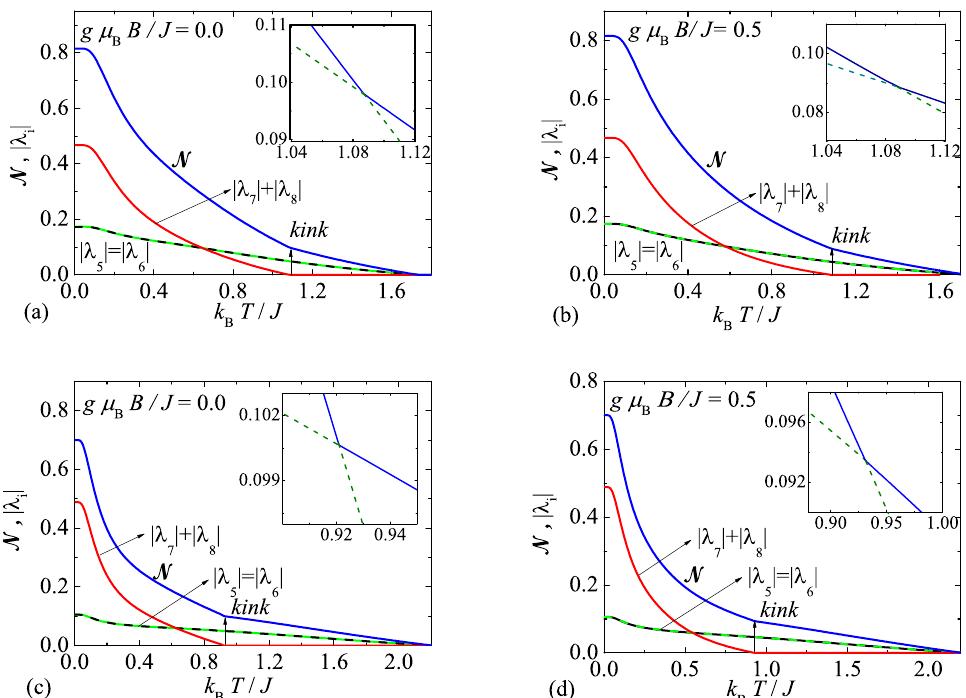
Figure 4. ( a , b ) Temperature dependencies of the overall negativity N and its three individual contributions N 1 , N 2 , and N 3 for the spin-1 Heisenberg dimer with the isotropic exchange coupling ∆ = 1, the uniaxial single-ion anisotropy D / J = − 2.0 and two different magnetic fields: ( a ) B = 0; (b) g µ B B / J = 0.5; ( c , d ) The same as in the panel ( a , b ) just for the uniaxial single-ion anisotropy D / J = − 4.0. The insets show a kink of the negativity in an enhanced